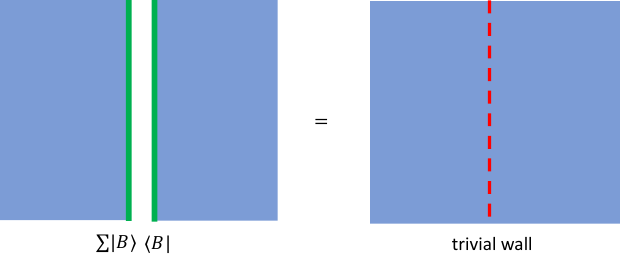
Figure 6 . Cutting the manifold and summing over the boundary conditions P equivalent to inserting the identity interface.